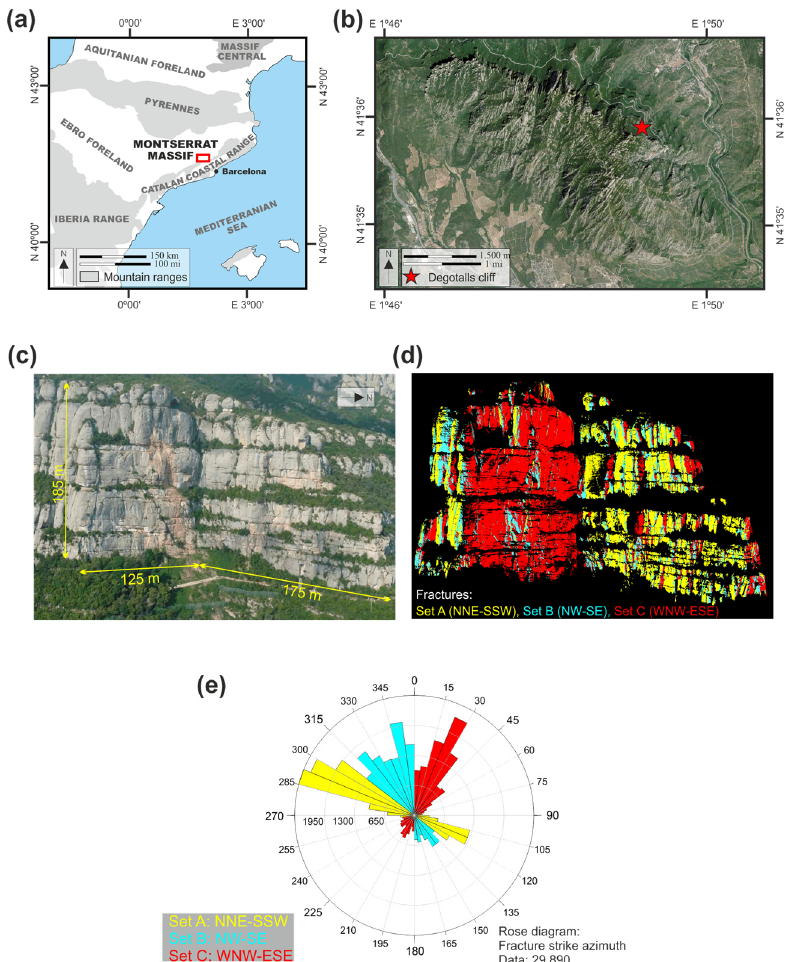
Figure 6. ( a ) Regional setting of the Montserrat massif, on the boundary of the Catalan Coastal Range and the Ebro Foreland Basin. ( b ) Degotalls Cliff location (41°35 ′ 54 ″ N, 1°50 ′ 00 ″ E). Orthoimage of the area (source: Cartographic and Geological Institute of Catalonia), the Montserrat sanctuary is 600 m to the SW. ( c ) Degotalls study area. Left side, Degotalls N orientated E-W, and right side Degotalls E with N-S orientation. ( d ) Fracture orientations in Degotalls rock cliff. ( e ) Strike azimuth rose diagram of the fractures modeled with TLS.